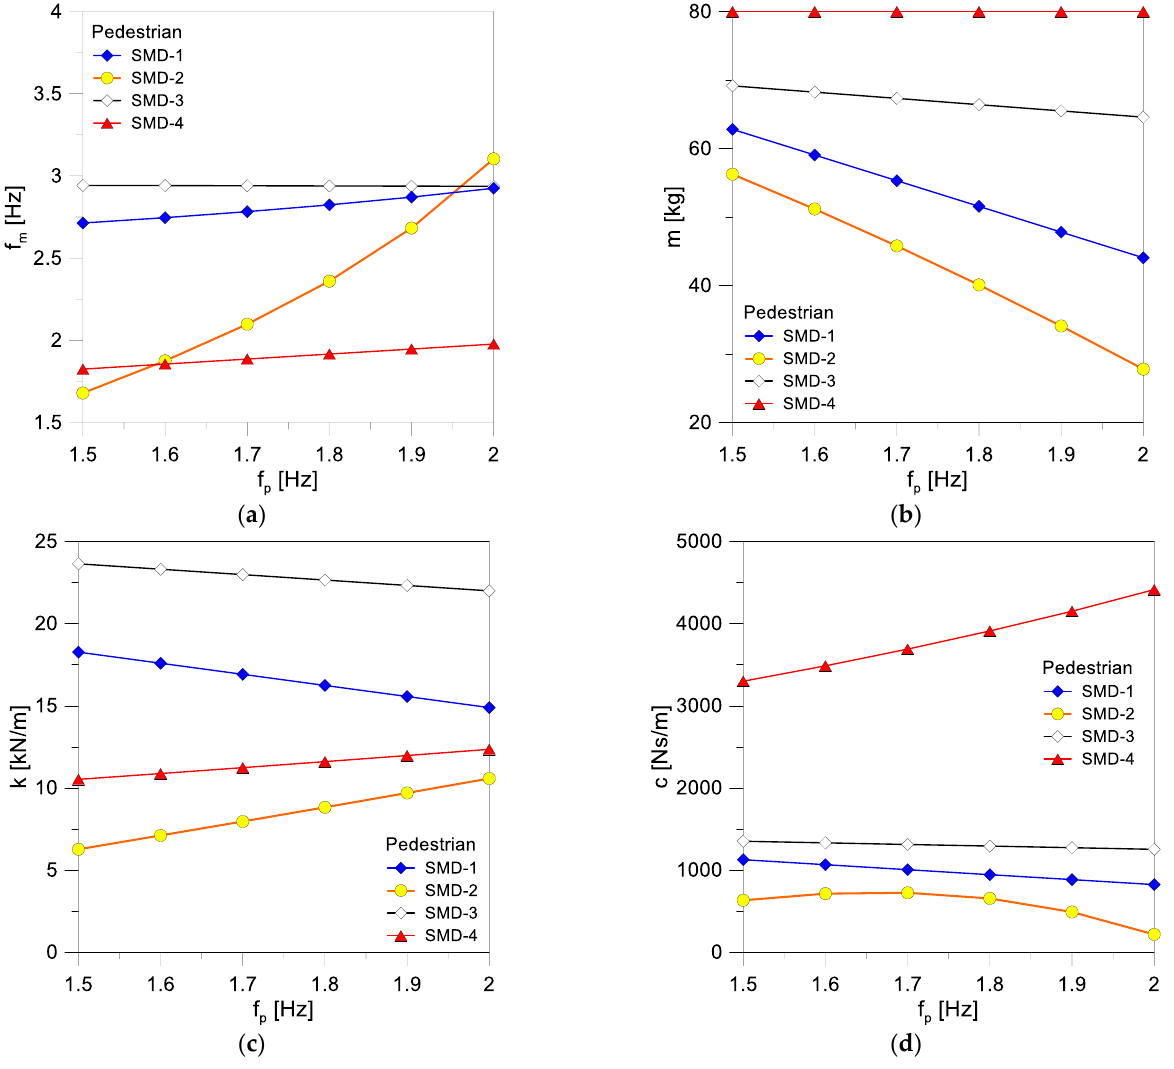
Figure 4. Selected biodynamic pedestrian models (with M = 80 kg) and variation of input SMD parameters with walking frequency f p : ( a ) pedestrian model frequency f m , ( b ) equivalent mass m , ( c ) spring stiffness k , ( d ) damping coefficient c .